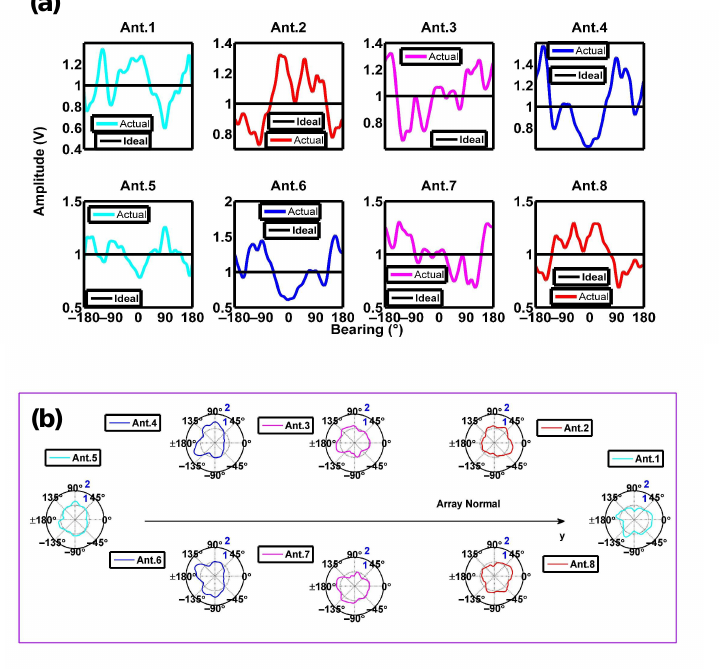
Figure 10. Amplitude patterns of the eight antennas: ( a ) C m ( θ ) in Cartesian coordinates; ( b ) C m ( θ ) in polar